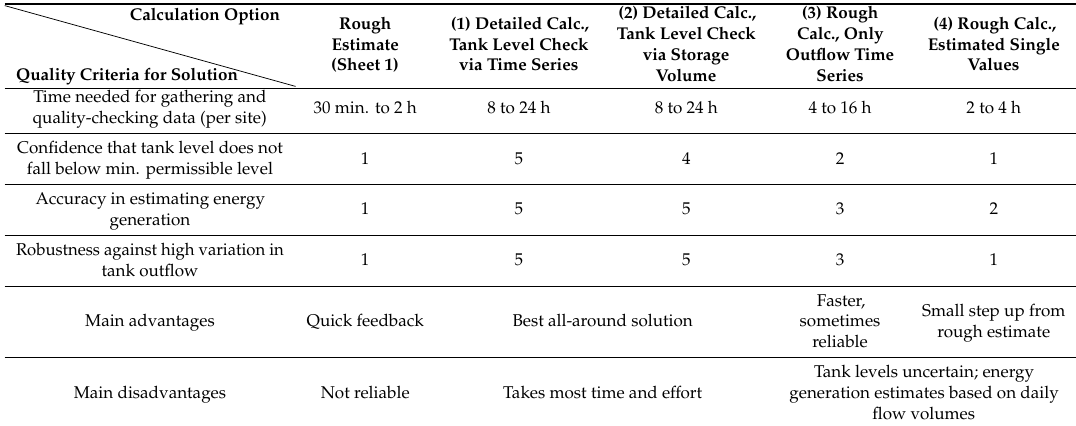
Table A2. Quality criteria for solutions provided by the Excel tool, depending on the chosen calculation option, where 1 = lowest and 5 =